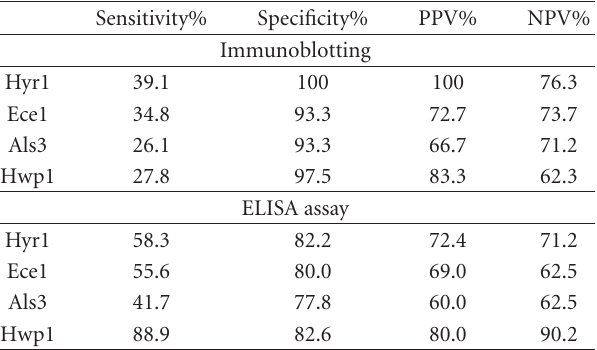
Table 2: Diagnostic usefulness of the detection of antibodies against Hyr1, Ece1, Als3, and Hwp1 by immunoblotting and ELISA assay [18] (PPV: positive predictive value, NPV: negative predictive